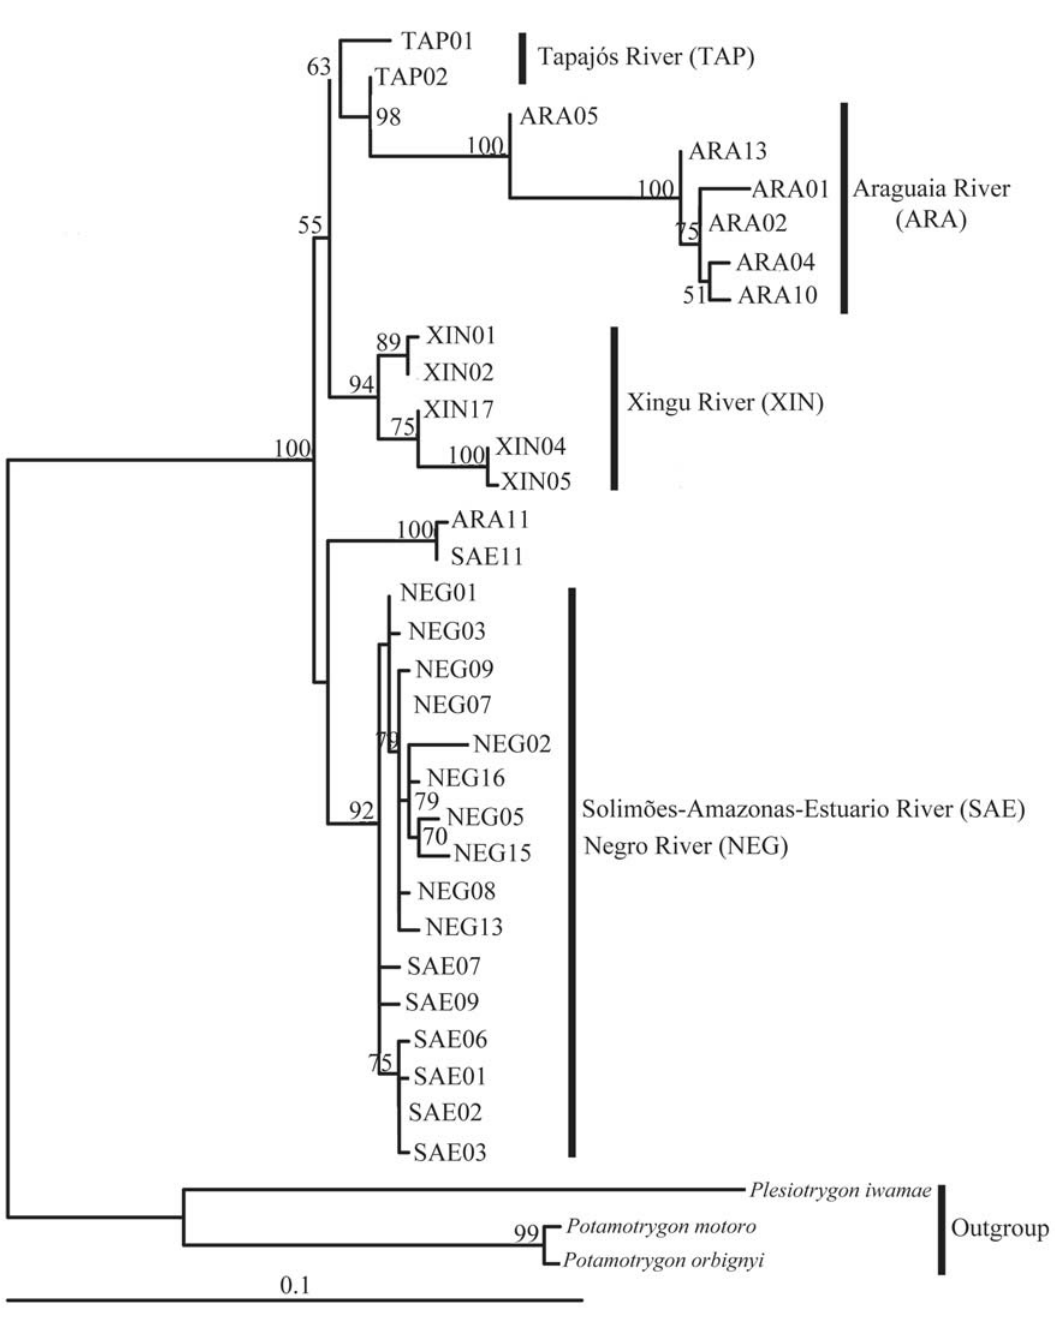
Fig 3. Maximum likelihood (ML) tree based on the analysis of the ATPase 6 gene of the Paratrygon aiereba . Numbers above the line are maximum likelihood edge support